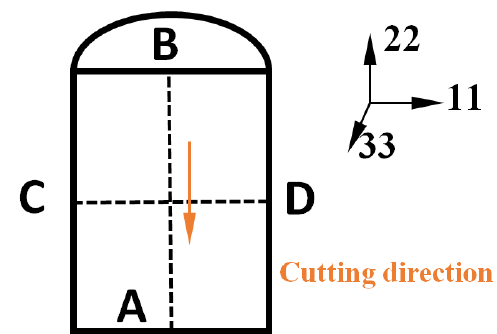
Figure 45. Specimen 3—line segments used for comparing the stress levels.